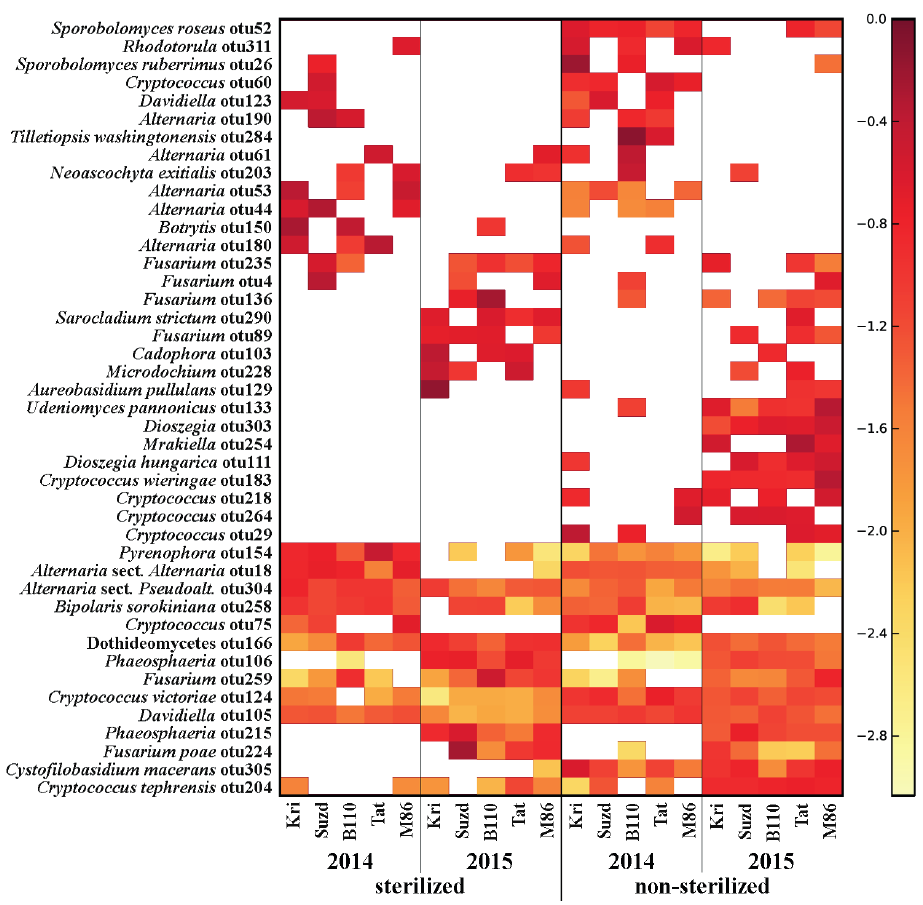
Figure 6 Fungal taxa heat map of sterilized and non-sterilized grain samples harvested in 2014 and 2015. OTUs are grouped according to UPGMA clusterization of Bray-Curtis dissimilarity matrix representing coexistence of OTUs within samples. Read counts of each OTU were weighted according to sum of reads in the sample, and then the proportion of the OTU dominance between samples was calculated and log-transformed. White corresponds to OTU absence in sample and red to OTU with high relative abundance across the samples Kri –Krinichnyy, Suz – Suzdalets, B110 – Belgorodskiy 110, Tat – Tatum, and M86 – Moskovskiy